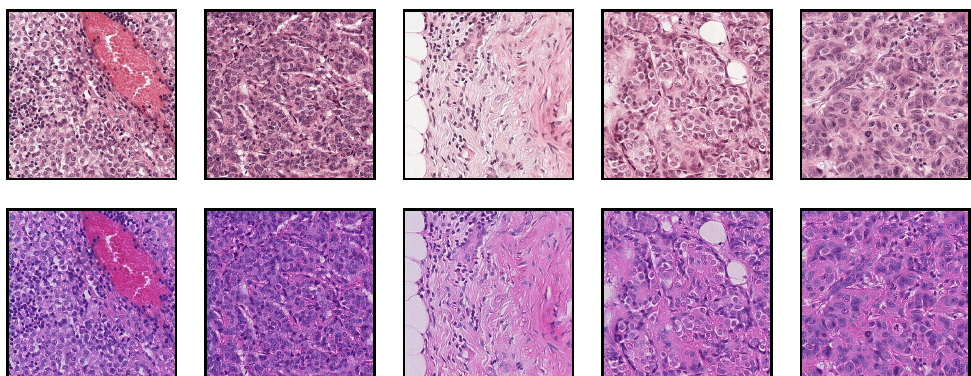
Figure 9. Exemplary tiles from the RUMC dataset (top row) and the transformed tiles after applying the stain normalization for the UMCU dataset (bottom row) using StainCUT.